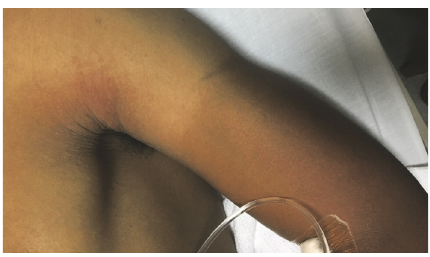
Figure 2: Well defined erythema over exposed surface of left arm and miliaria rubra lesions over